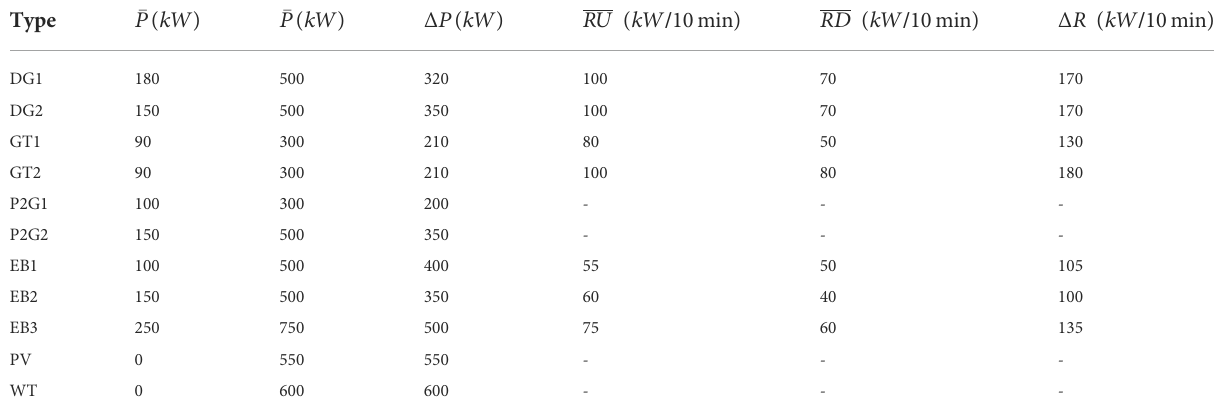
TABLE 1 Main parameters of units in MEMG.